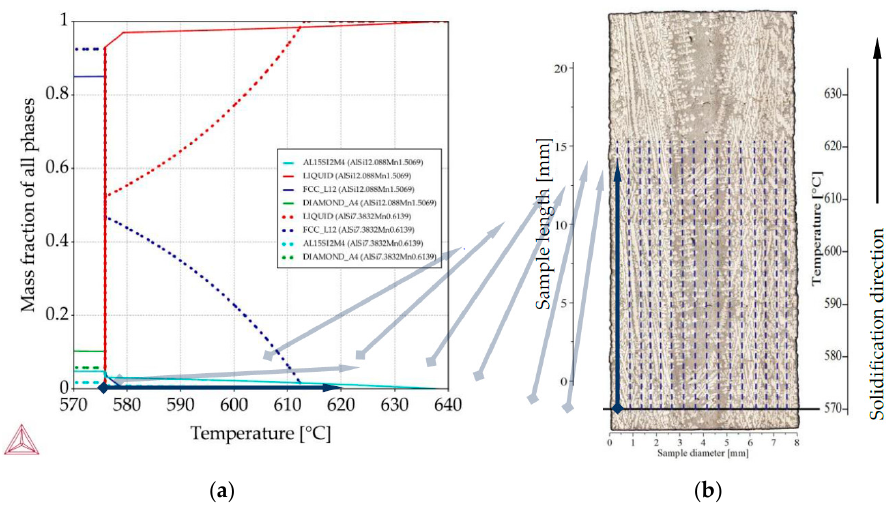
Figure 4. Methodology of 2D maps construction based on property diagrams. Blue arrow shows the transformation of temperature axis from property diagram onto longitudinal section and its placement along sample length in specified places along sample diameter: ( a ) property diagram for AlSi9Mn1.0 specimen, for places with chemical composition AlSi12.08Mn1.50 and AlSi7.38Mn0.61; ( b ) longitudinal section with marked sites (dashed lines) for mass fraction placement.